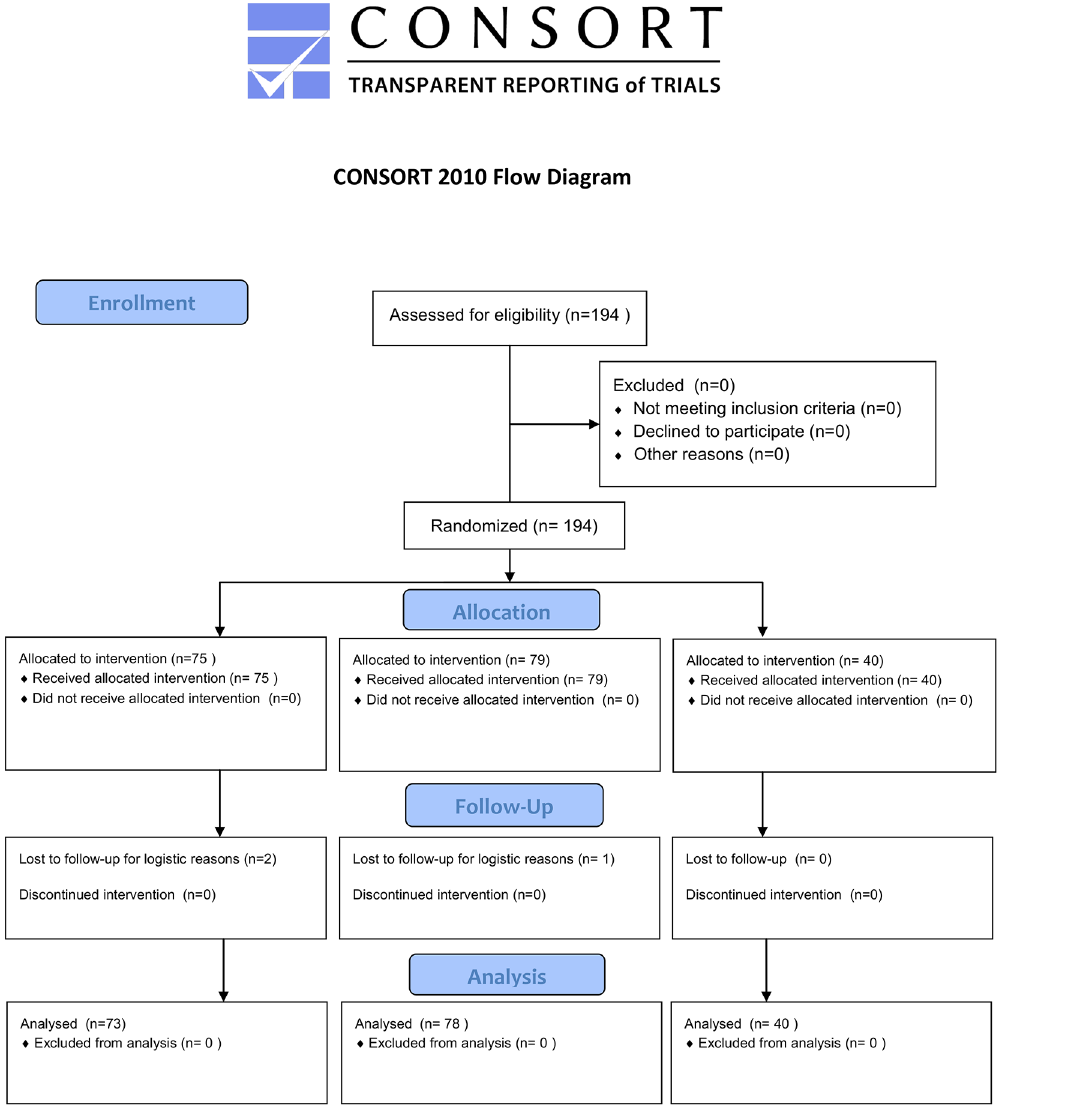
Fig 1. Consort Flow Diagram according to the CONSORT reporting guidelines.